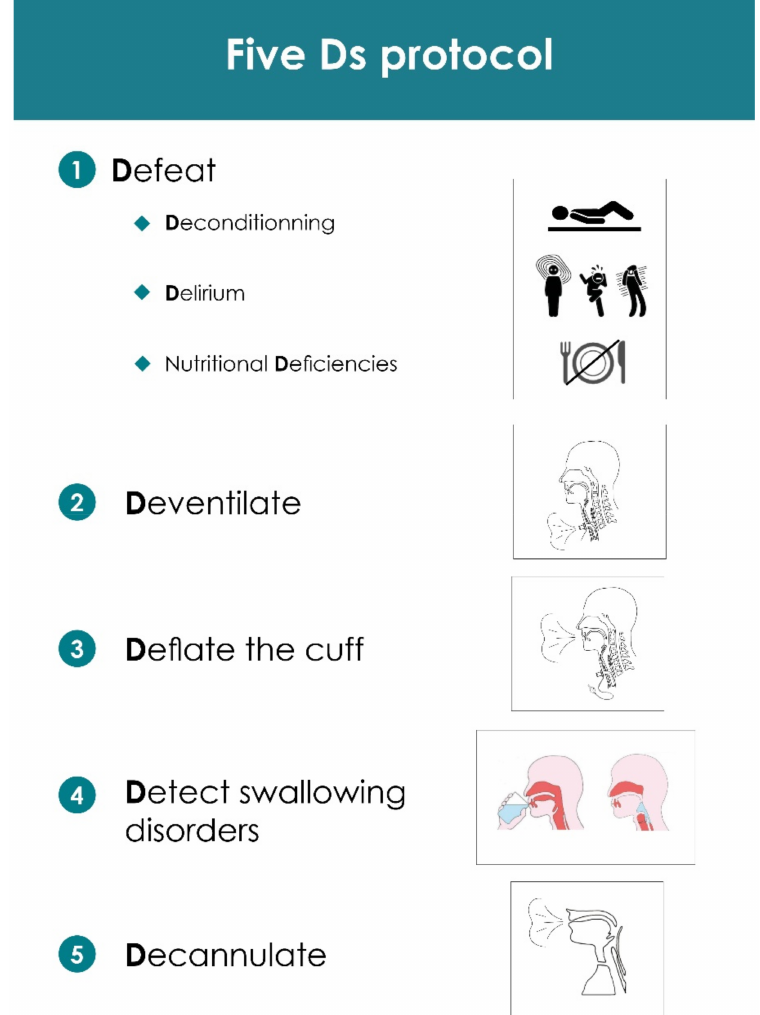
Figure 1. Illustration of the 5 Ds protocol up to the patients’